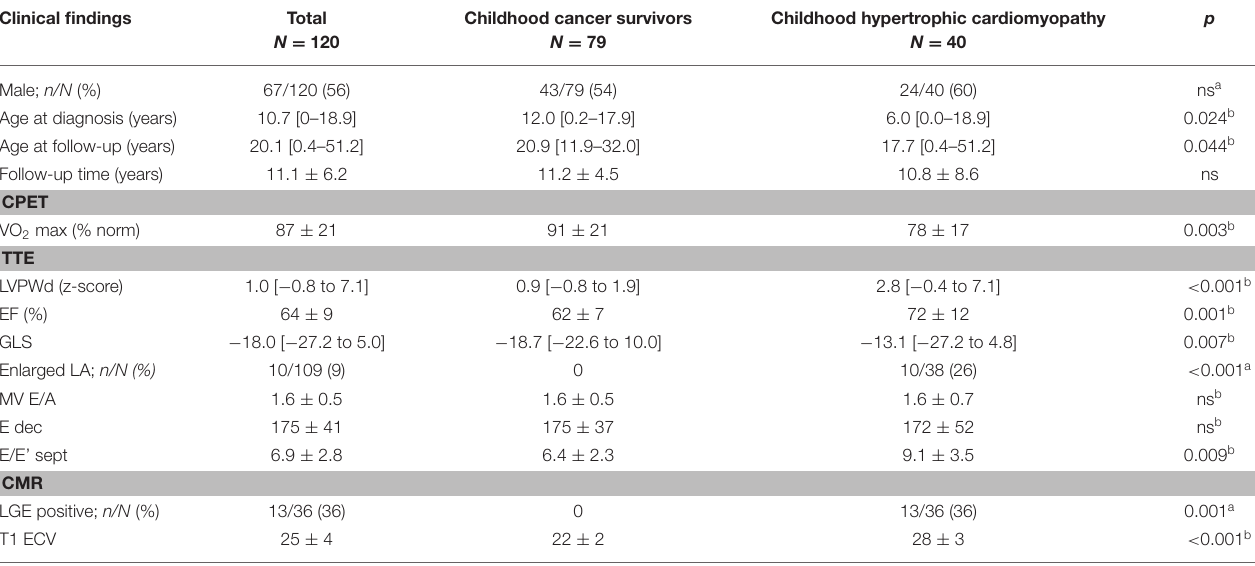
Data are shown as mean ± standard deviation or median [range] according to data distribution. a Fishers exact Test. b independent t-Test or Mann-Whitney-Test according to data distribution. n/N, number of patients; ns, not significant; CPET, cardiopulmonary exercise testing; VO 2 max (% norm), peak respiratory oxygen uptake in % predicted; TTE,